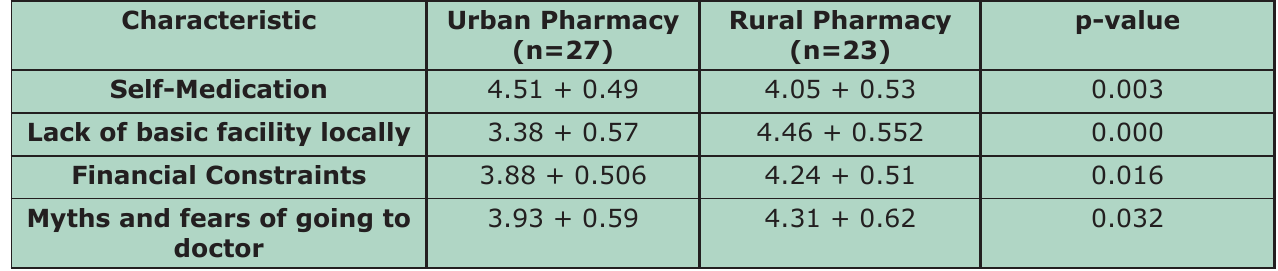
Table-III: Reasons for requesting pharmacies for drug purchases without doctors' prescriptions.